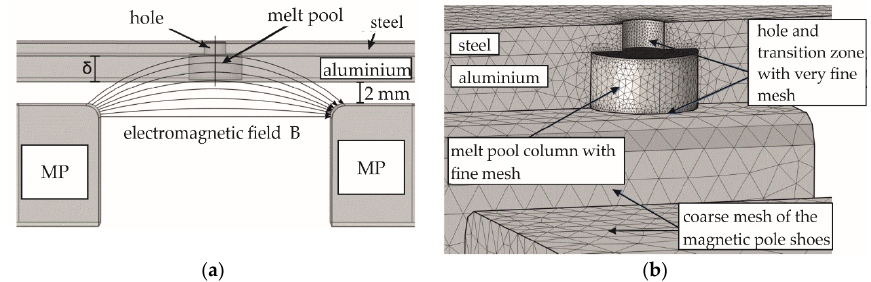
Figure 5. Three-dimensional model ( a ), different meshed regions of the three-dimensional model ( b ).